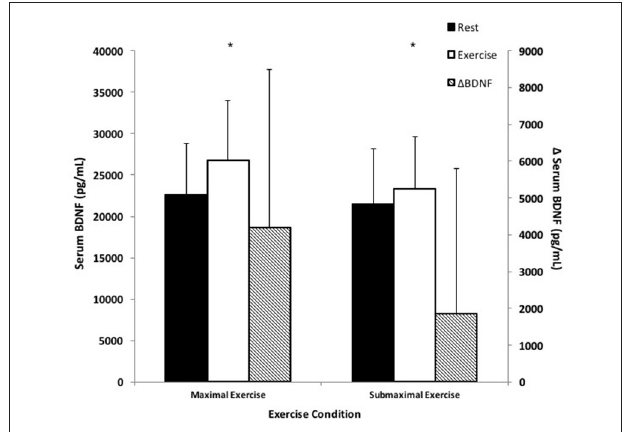
FIGURE 1 | BDNF responses to small muscle mass exercise. Total serum BDNF at rest (black bars) and total serum BDNF during exercise (white bars) correspond with the left y-axis. 1 BDNF represents the difference between exercise and rest BDNF (hatched bars) and corresponds with the right y-axis. *Significantly different compared to rest, p <